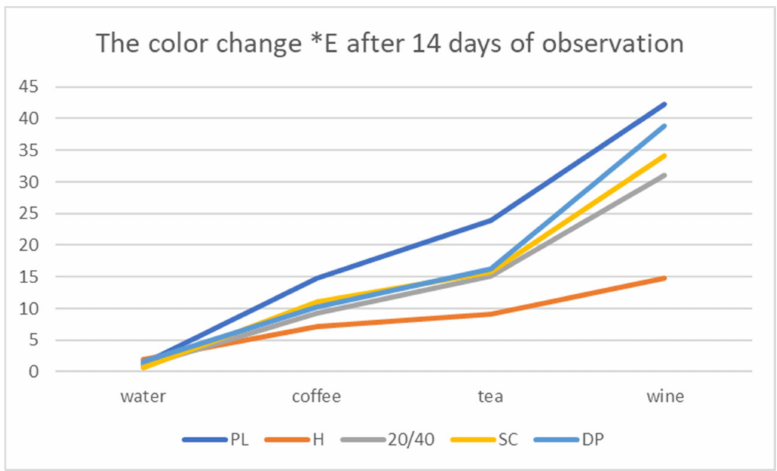
Figure 6. The color change ∆ E* after 14 days of observation in relation to the type of brackets and kind of storage